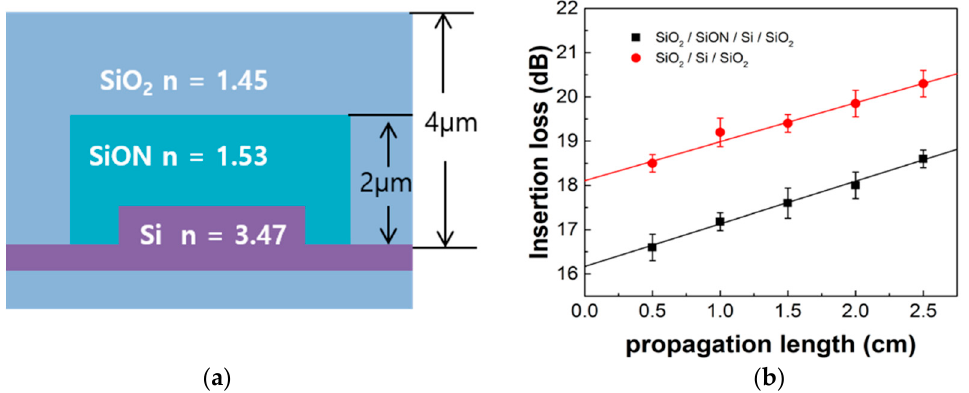
Figure 1. ( a ) The optical waveguide cross-section; ( b ) the insertion losses of two waveguides (square: SiO 2 /SiON/Si/SiO 2 waveguide; circle: SiO 2 /Si/SiO 2 waveguide). SiO 2 / SiON / Si / SiO 2 waveguide; circle: SiO 2 / Si / SiO 2